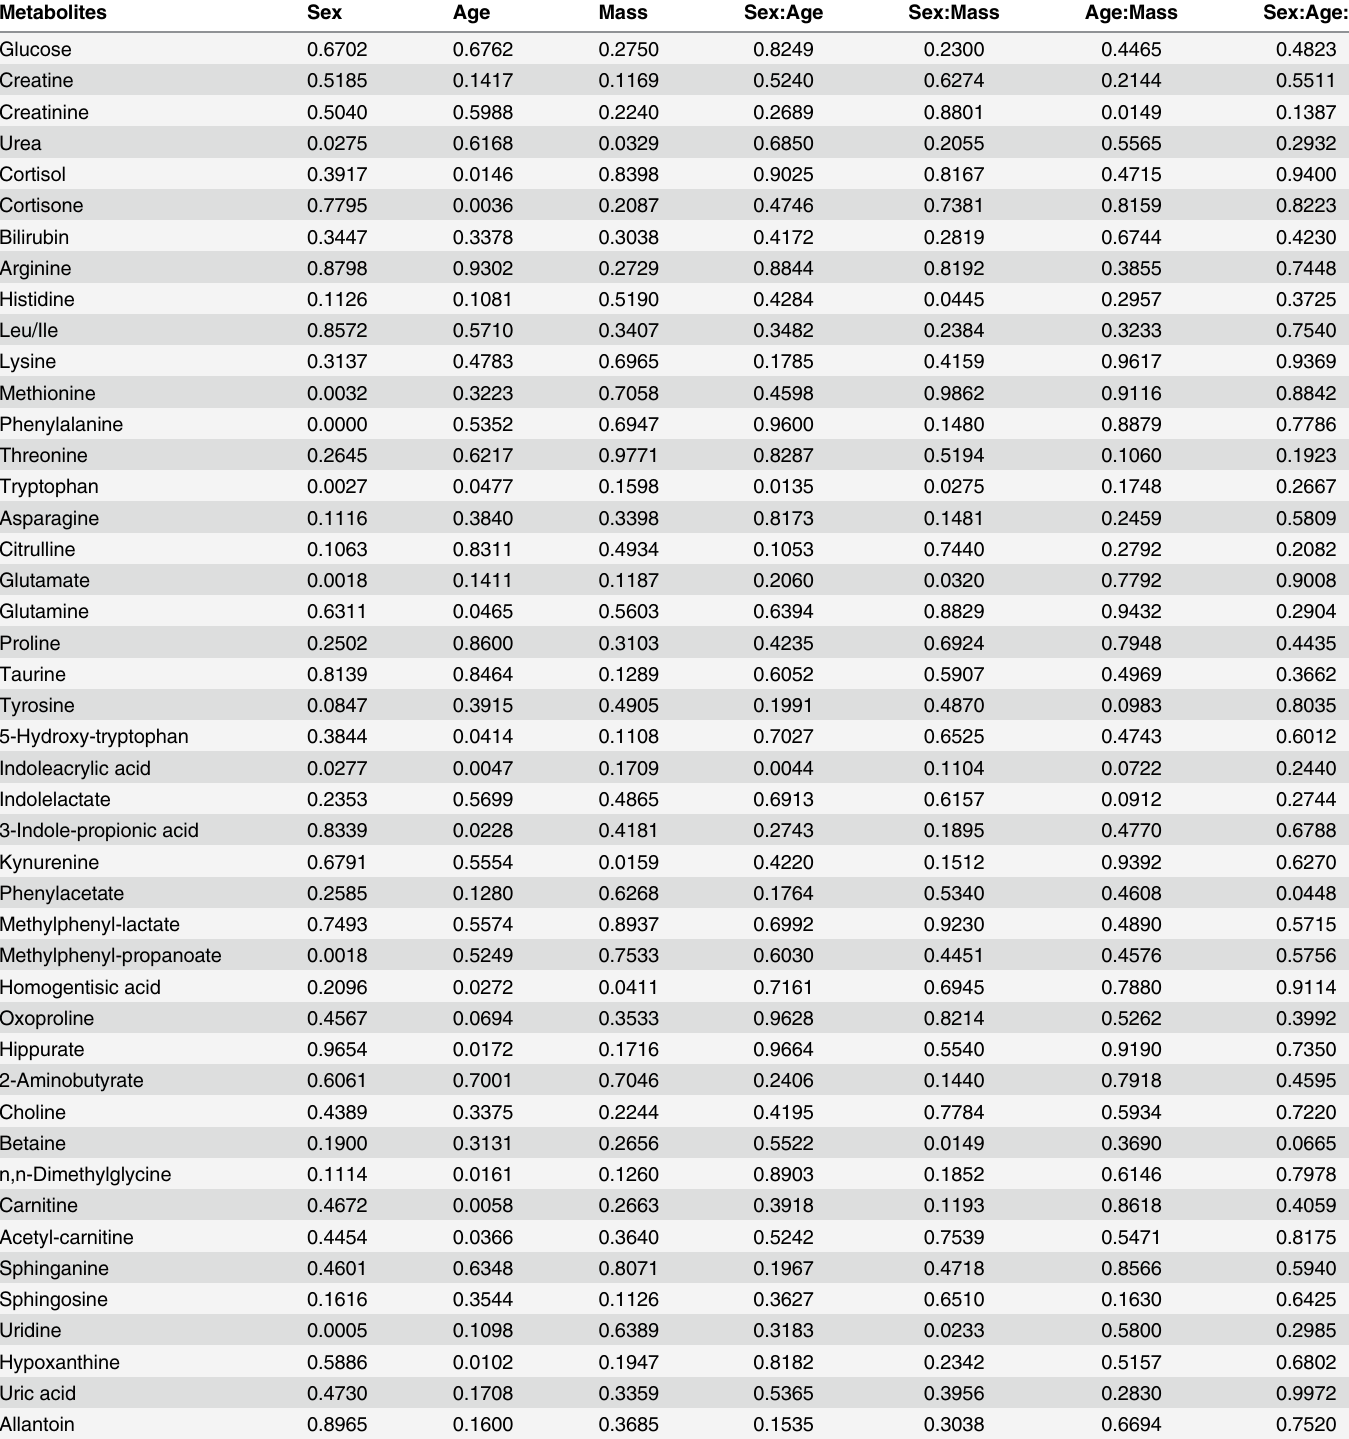
Table 3. ANCOVA p -values on feature-by-feature basis for association with age, sex, and body